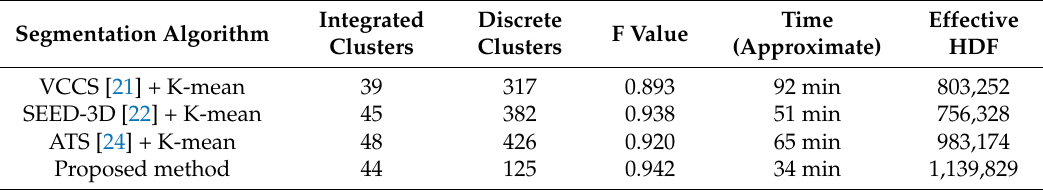
Table 4. The segmentation evaluation of four segmentation